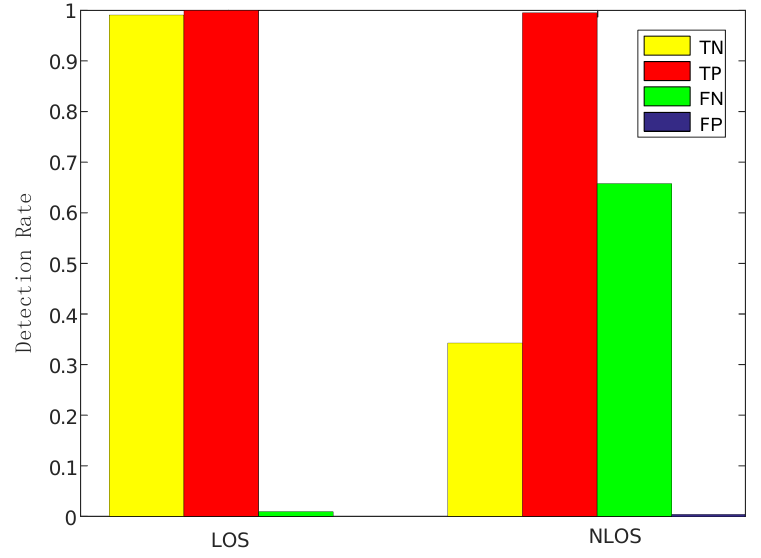
Figure 14. Detection rates of line-of-sight (LOS)/NLOS.